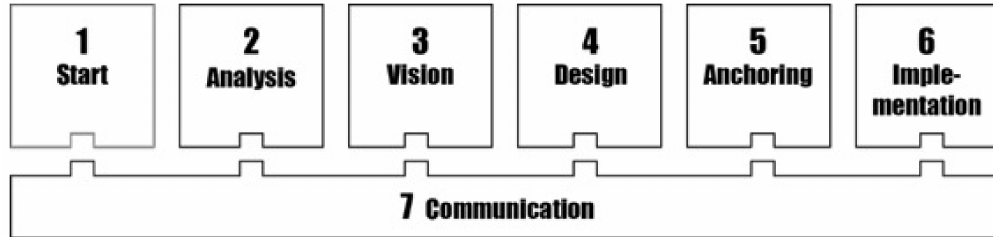
Figure 2. The campus development process stages developed by Akademiska